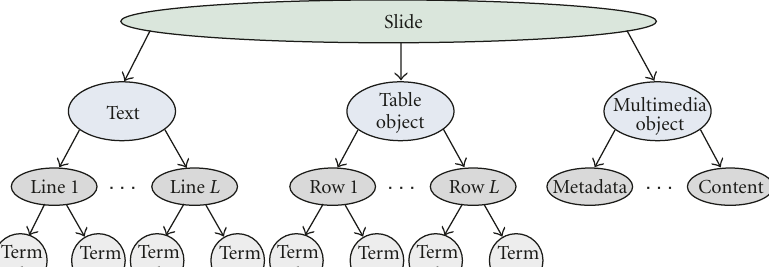
Figure 3: Slide structure.